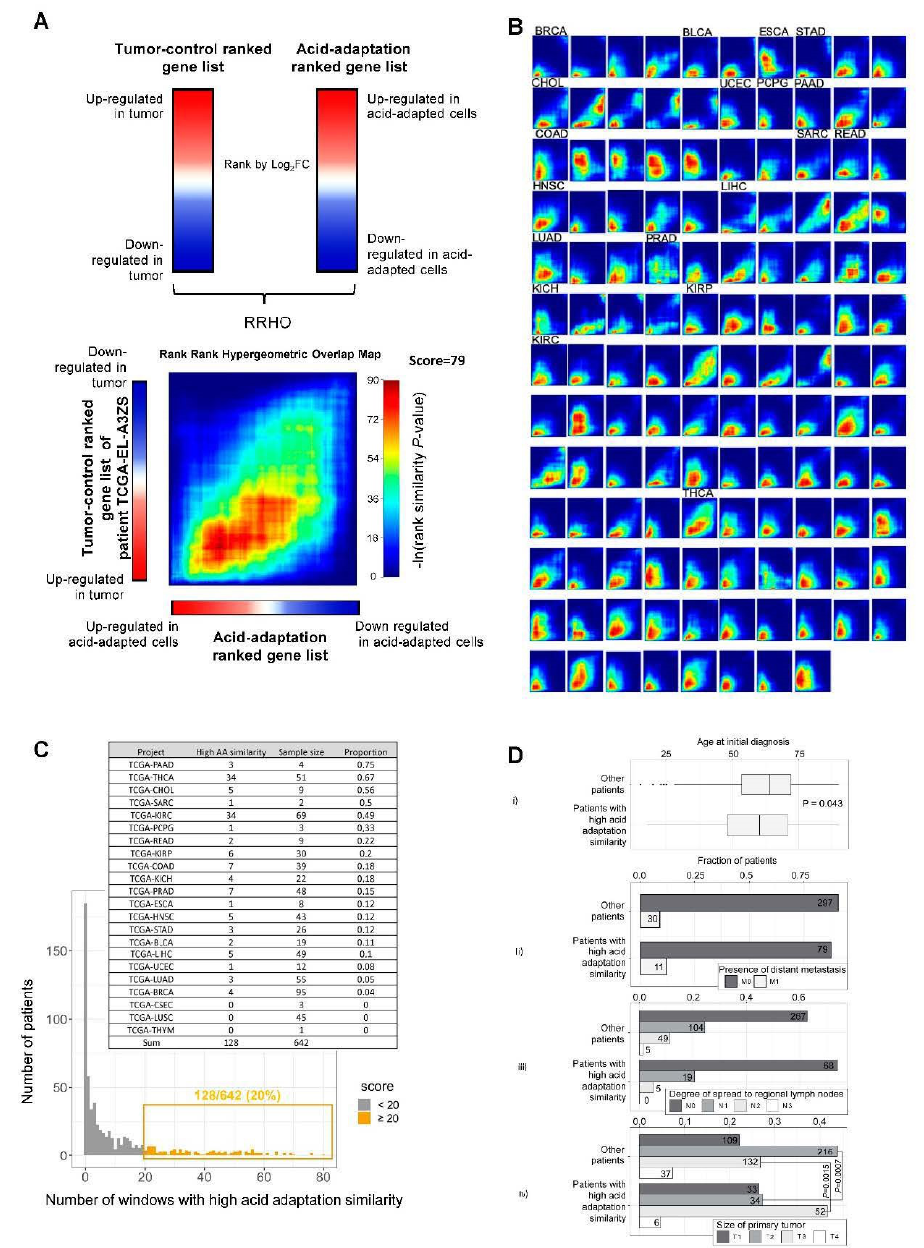
Figure 4. Rank–rank analysis of acid adaptation and patient tumor–ctrl. ranked gene lists. ( A ) Conceptual overview of rank–rank hypergeometric overlap (RRHO) analysis. Genes are ranked by their log2 fold expression change based on either tumor–ctrl. comparison for a given patient (left) or by acid adaptation response (pH 6.5 vs. 7.6). These ranked gene lists are compared in the rank–rank heat map below (exemplified by the comparison of data from the TCGA patient TCGA-EL-A3ZS and the acid adaptation gene list), identifying windows of genes with correlated ranks in respective gene lists and the significance of such correlated ranks, as indicated by color (based on ln(hypergeometric p -values) as shown). ( B ) Heat maps resulting from patient tumor–ctrl. vs. acid adaption gene list RRHO analyses showing high gene rank similarity. Each heat map corresponds to patient tumor–ctrl. vs. acid adaptation gene list analysis as in A, where the acid adaptation gene list is always at the x -